Question: What form of chart is displayed?
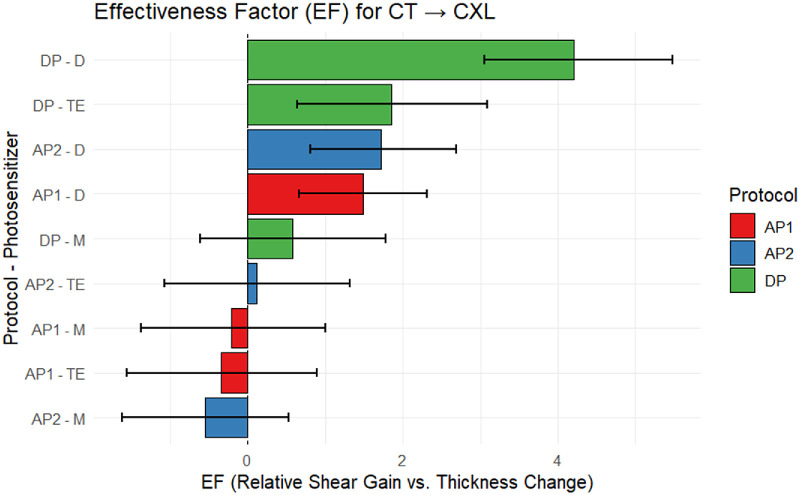
Answer: bar